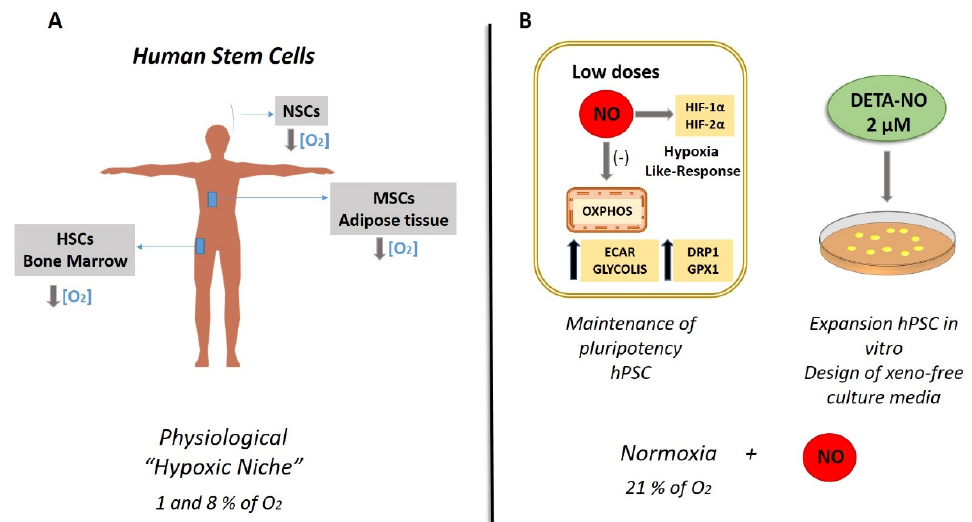
Figure 2. Physiological human stem cell niches versus nitric oxide-based in vitro cultures. ( A ) Hy- poxic niches of stem cells (SCs). The figure shows the O 2 tensions characteristic of the biological niches of MSCs, NSCs, and HSCs. Various studies have determined by direct measurement or applying various mathematical models the O 2 tension in bone marrow, adipose tissue, and the ventricular zone of the brain where the respective SCs reside. The results showed levels between 1 and 8% of O 2 , revealing an O 2 tension lower than the atmospheric one (21% of O 2 ). Direct measurements in the brain have not been carried out, but tensions of 0.55% O 2 have been recorded in other regions in rodents, and conceptual translation to humans has been carried out. MSCs (mesenchymal SCs); NSCs (neural SCs); HSCs (hematopoietic SCs) [76]. ( B ) Low DETA-NO in normoxia (21% O 2 ) encourages a response similar to hypoxia in PSCs. Therefore, exposure to 2 µ M DETA-NO led to the accumulation of HIF-1 α and HF-2 α proteins, increased expression of pluripotency genes NANOG and OCT-4 , and a shift towards the expression of genes favoring glycolitic metabolism. Mitochondrial functions and dynamics were also affected, with a decrease in OXPHOS, an increase in ECAR and DRP1 expression. These actions are not dependent on changes in mROS levels while GPX1 mRNA expression increase, which is compatible with the maintenance of pluripotency as it is described in the review. All in all, these outcomes indicate that NO induces a hypoxia-like response, regulating mitochondrial functionality and metabolic parameters in human PSCs, thus maintaining pluripo- tency [14]. In this context, the use of NO is proposed to supplement culture media for human PSCs (hPSCs) expansion. NO (nitric oxide); OCR (O 2 consumption rate); ECAR (extracellular